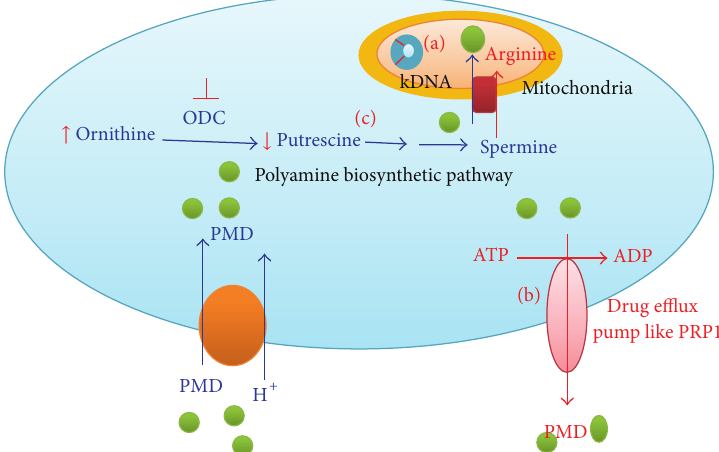
Figure 3: The mechanisms of pentamidine resistance in Leishmania . (a) Change in kDNA sequence confers resistance. The exact mechanism of conferring resistance remains unknown. (b) Presence of drug efflux pumps like PRP1 to remove the drug molecules from the cell and thus protect it from damage. (c) Reduced uptake of pentamidine in mitochondria due to altered polyamine biosynthetic pathways and lowered membrane potential. Blue lines indicate the probable drug action in sensitive Leishmania strains while red lines depict the probable routes to achieve resistance as observed in resistant